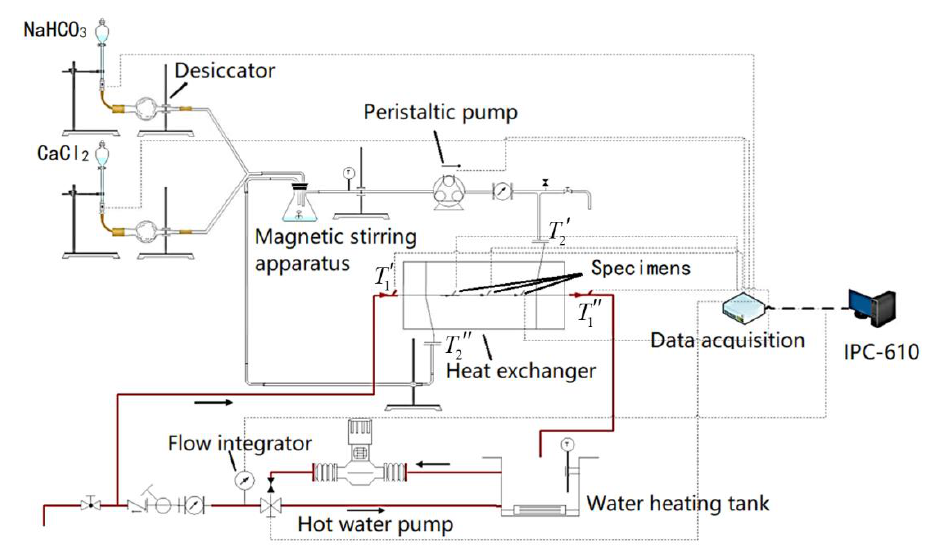
Figure 2. Schematic diagram of flow fouling experimental rig.